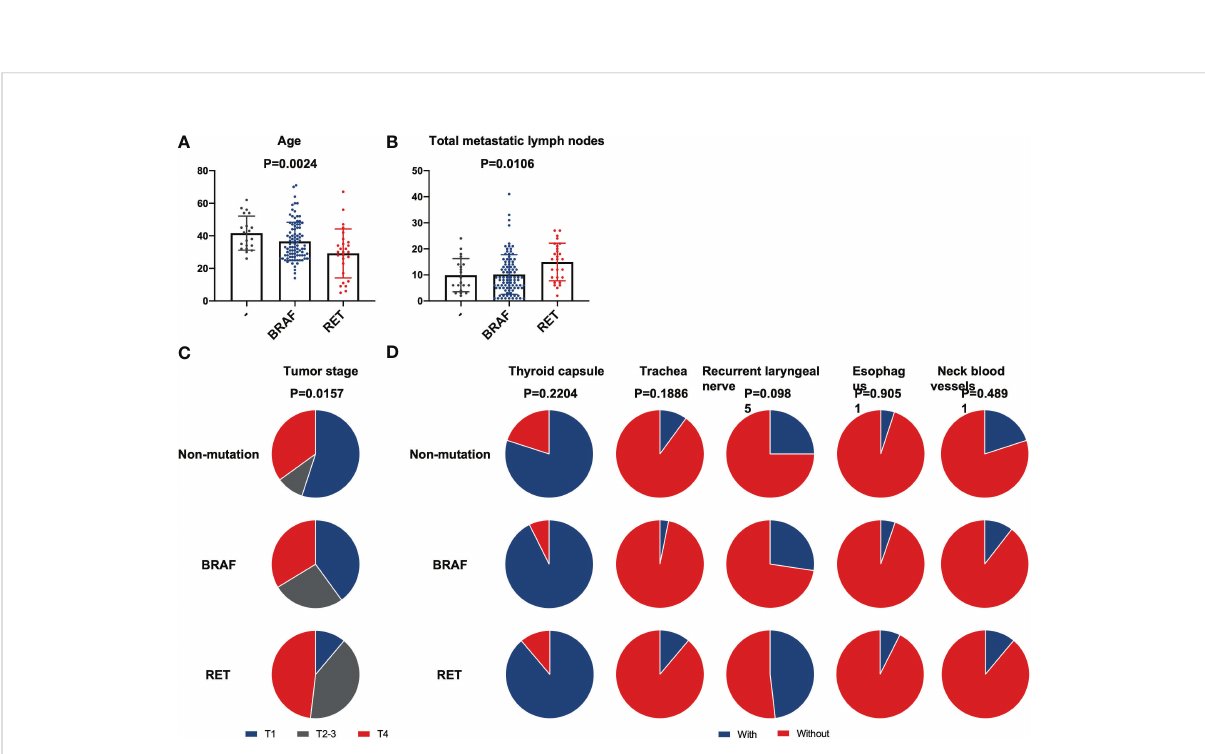
FIGURE 2 Comparison between BRAF , RET , and non-mutation. Differences in clinical characteristics between patients with BRAF mutation, RET fusion, and without mutation. (A) Patients ’ age; (B) Number of lymph node metastases; (C) Tumor stage; (D) Extrathyroidal invasion. No statistical differences in any extrathyroidal invasion exist between these three groups.